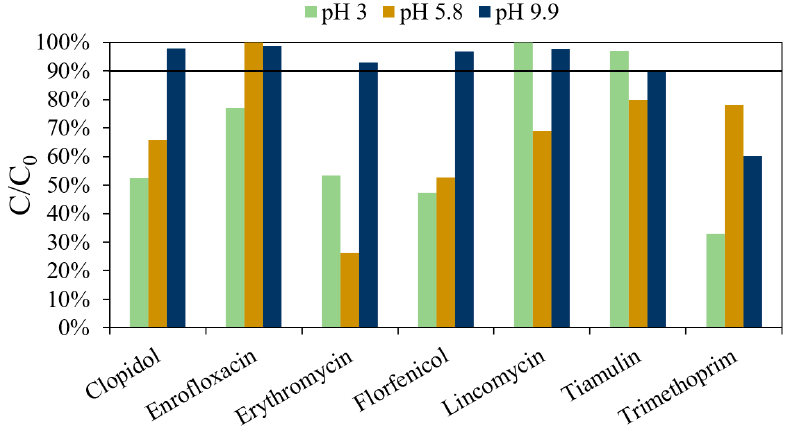
Figure 8. The pH value for 90% degradation efficiency of selected antibiotic by using UV/TiO 2 . [antibiotics] 0 = 50 μ g/L, [TiO 2 ] 0 = 0.1 g/L.